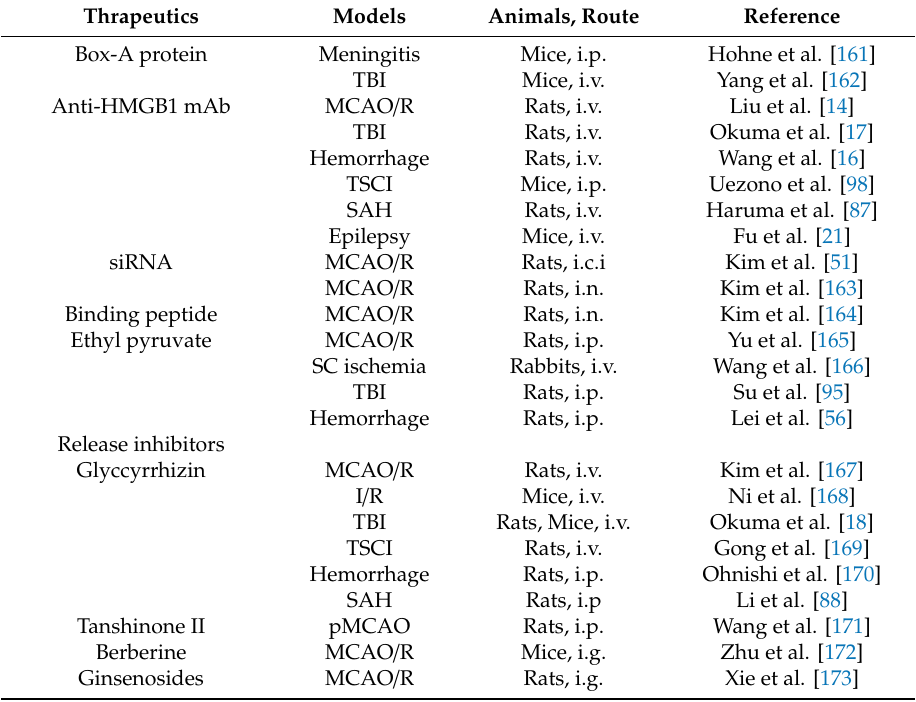
Table 1. E ff ects of di ff erent HMGB1 inhibitors on brain inflammation and BBB disruption. Thrapeutics Models Animals, Route